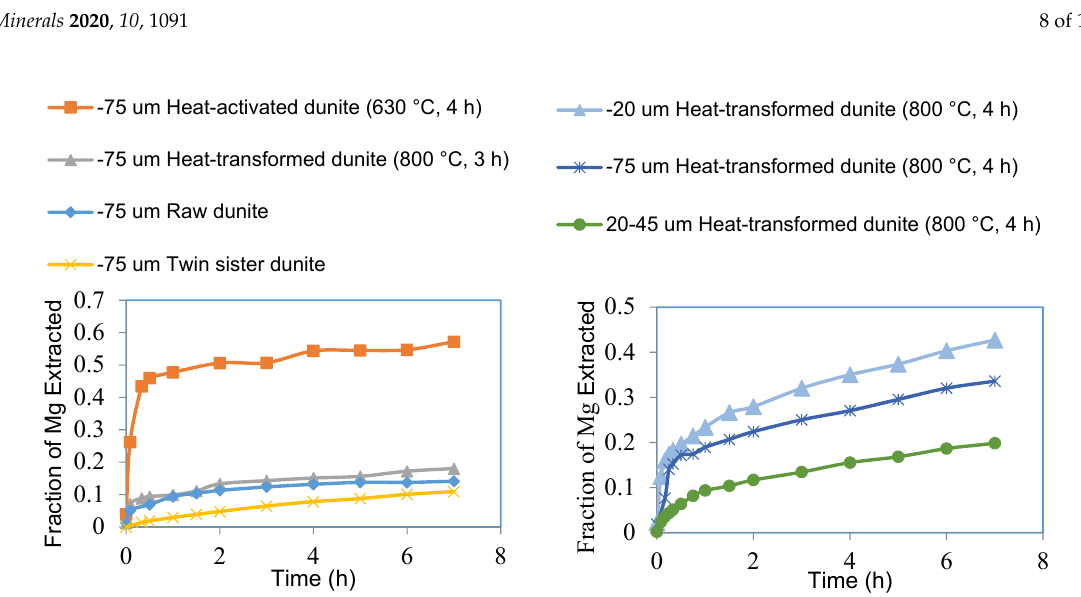
Figure 7. The extent of Mg extracted from sub-75 µm fractions of raw dunite, heat-activated dunite (630 °C, 4 h), heat-transformed dunite (800 °C, 3 h), and twin sister dunite (left). The extent of Mg extracted from different size fractions of heat-transformed dunite (800 °C, 4 h) (right).